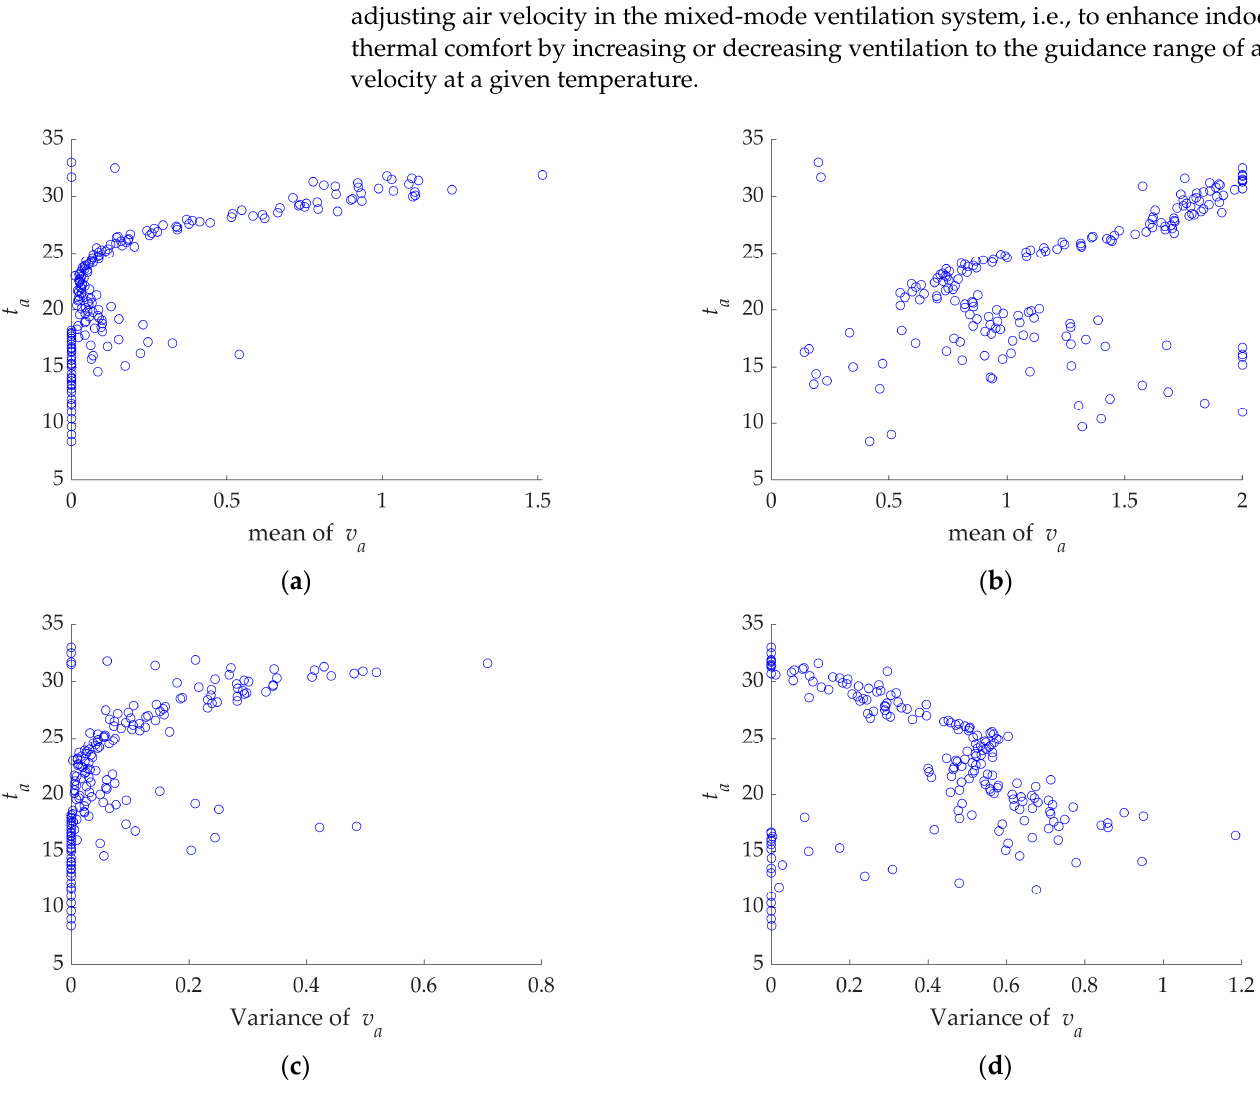
Figure 14. Scatter plot of mean and variance based on left and right endpoint values for all air-velocity adjustable intervals. ( a ) Mean values at the left endpoint. ( b ) Mean values at the right endpoint. ( c ) Variance values at the left endpoint. ( d ) Variance values at the right endpoint.